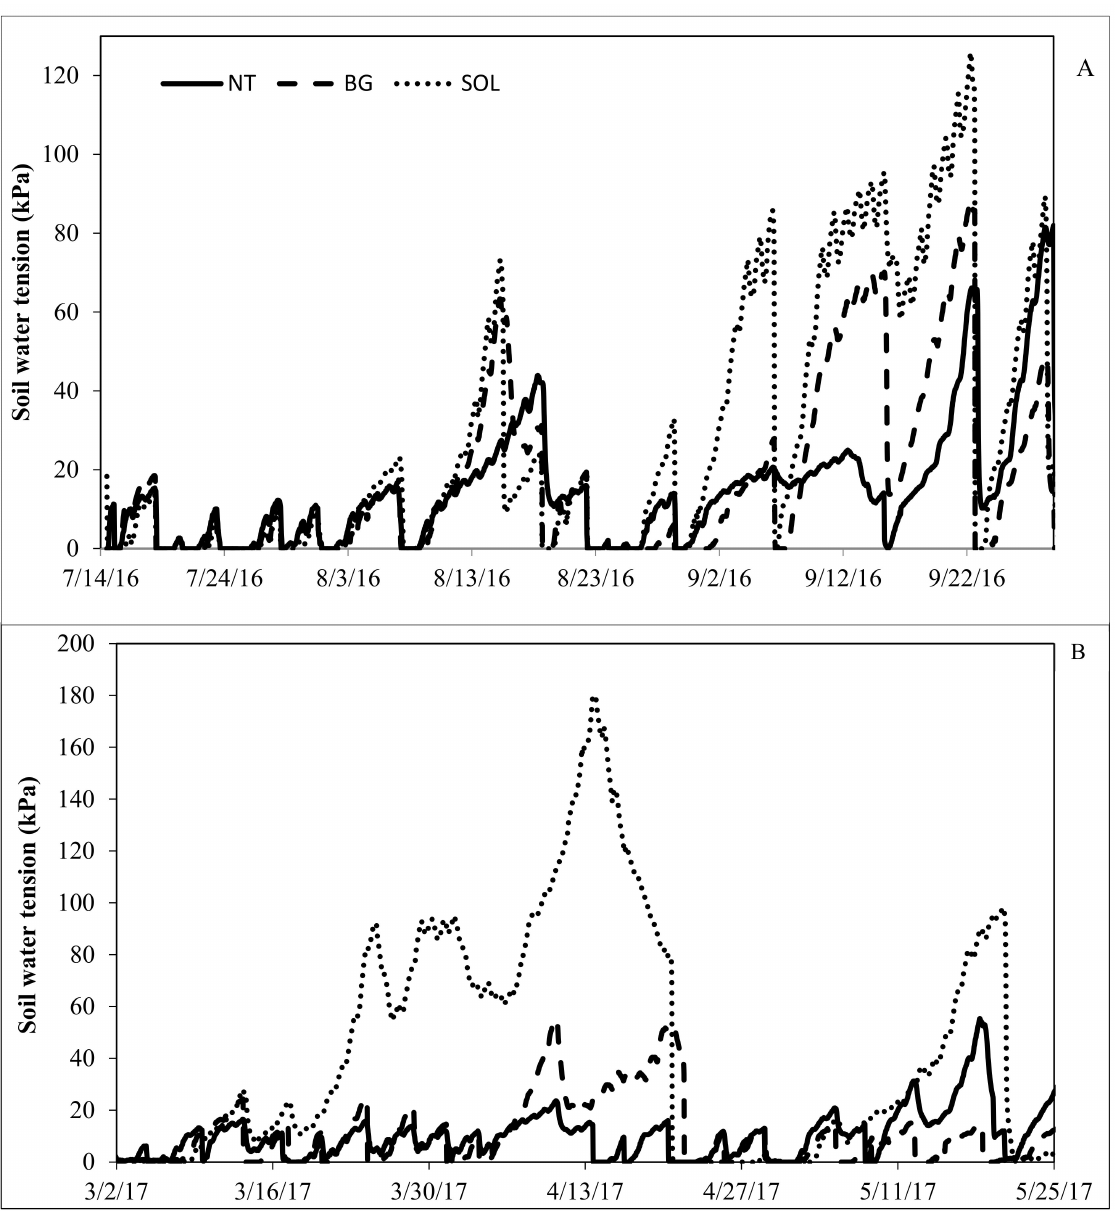
Figure 1. Soil water tension values recorded hourly throughout the 3 month corn growing period in ( A ) trial I and ( B ) trail II. BG = bare ground conventional tillage; BO = no-till with black oat cover crop; SOL =